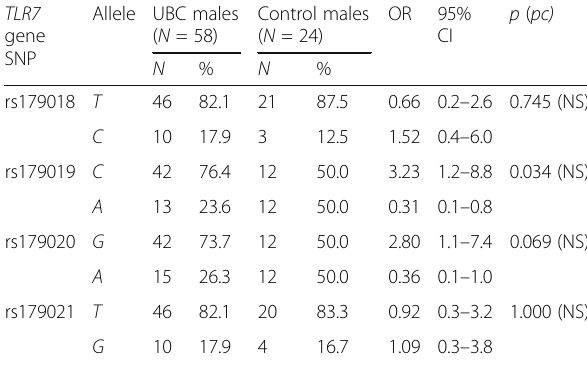
Table 3 Single-nucleotide polymorphisms of TLR7 gene in males of urinary bladder cancer patients and control